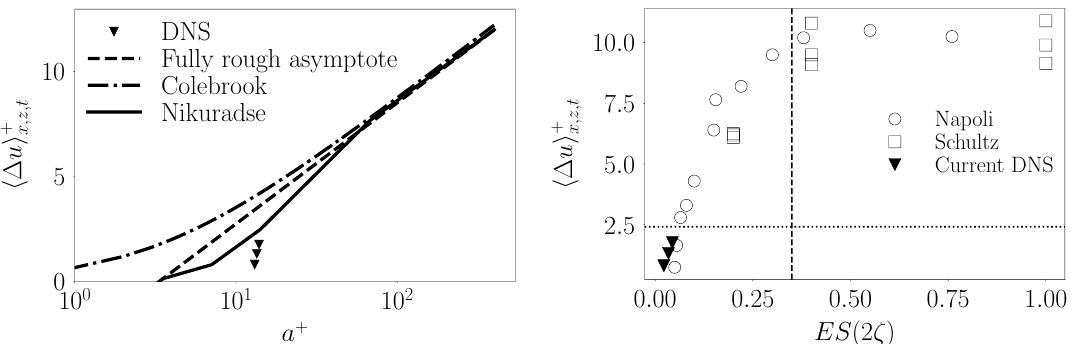
Figure 11. Variation of mean roughness function ( a ) with roughness Reynolds number and ( b ) with effective slope in comparison with reported data from known literature. In ( a ) we compare the roughness function from current DNS with the correlations of Nikuradse [3],Colebrook [4] and the fully rough asymptote (see Appendix A for the correlations). In ( b ) we show comparison with data from Napoli et al. [17] and Schultz et al.